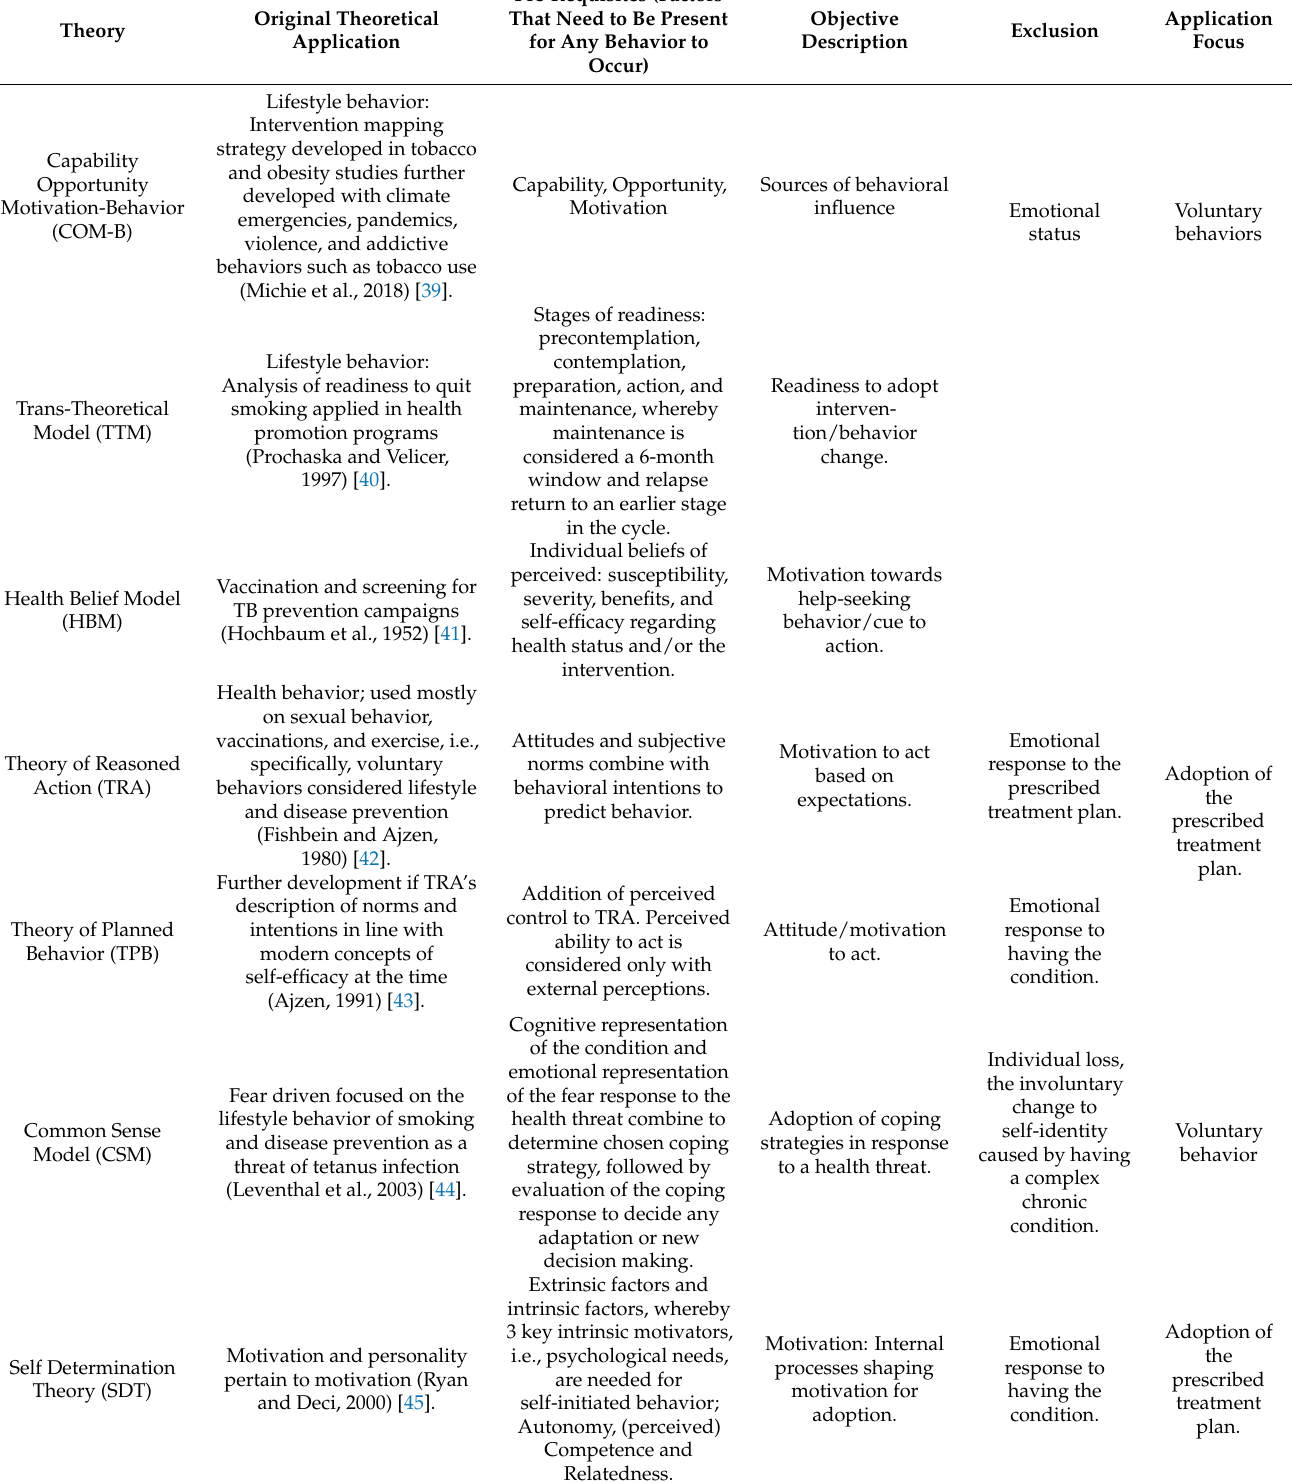
Table 1. Behavior change theory applied in audiology